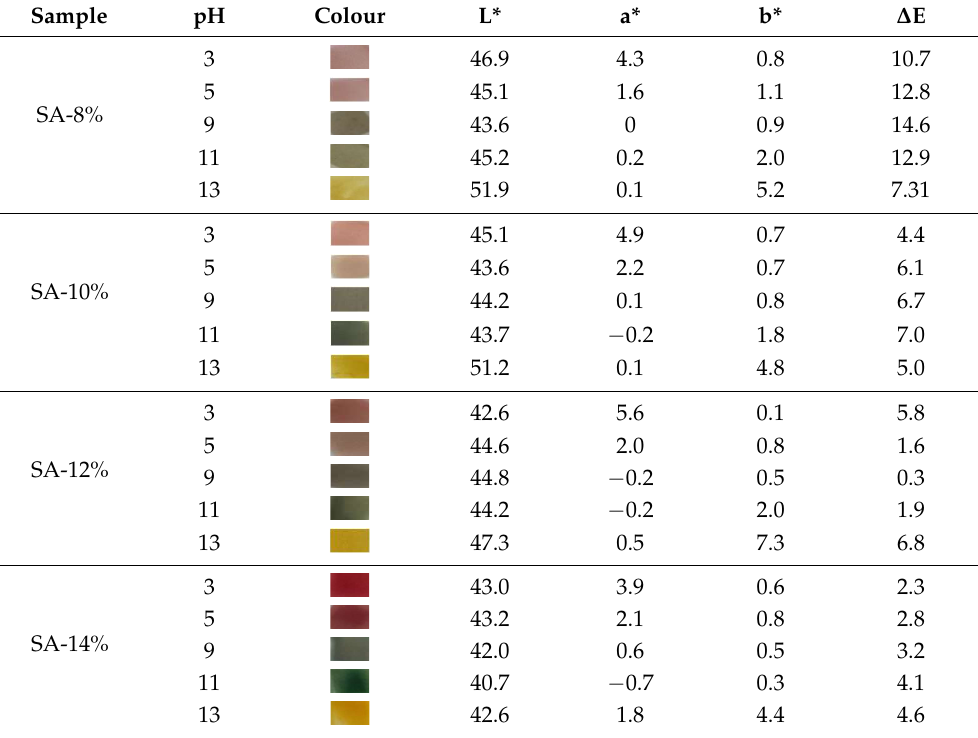
Table 5. The colour spectrum of the pH-sensitive films containing red cabbage as a function of pH.